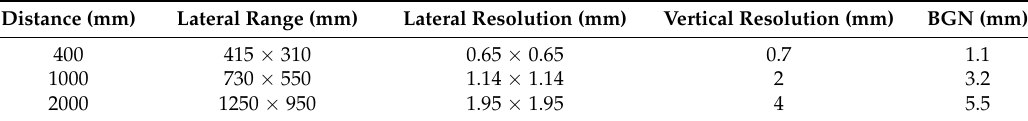
Table 1. Sensor scanning performance.